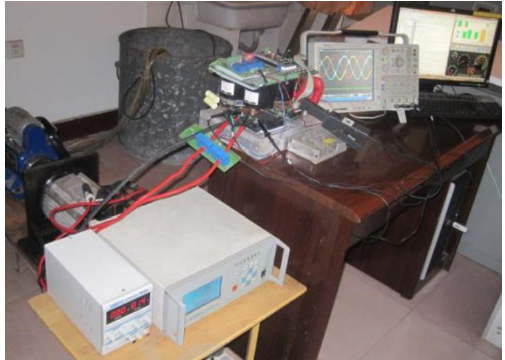
Figure 13. A picture of the experimental system.